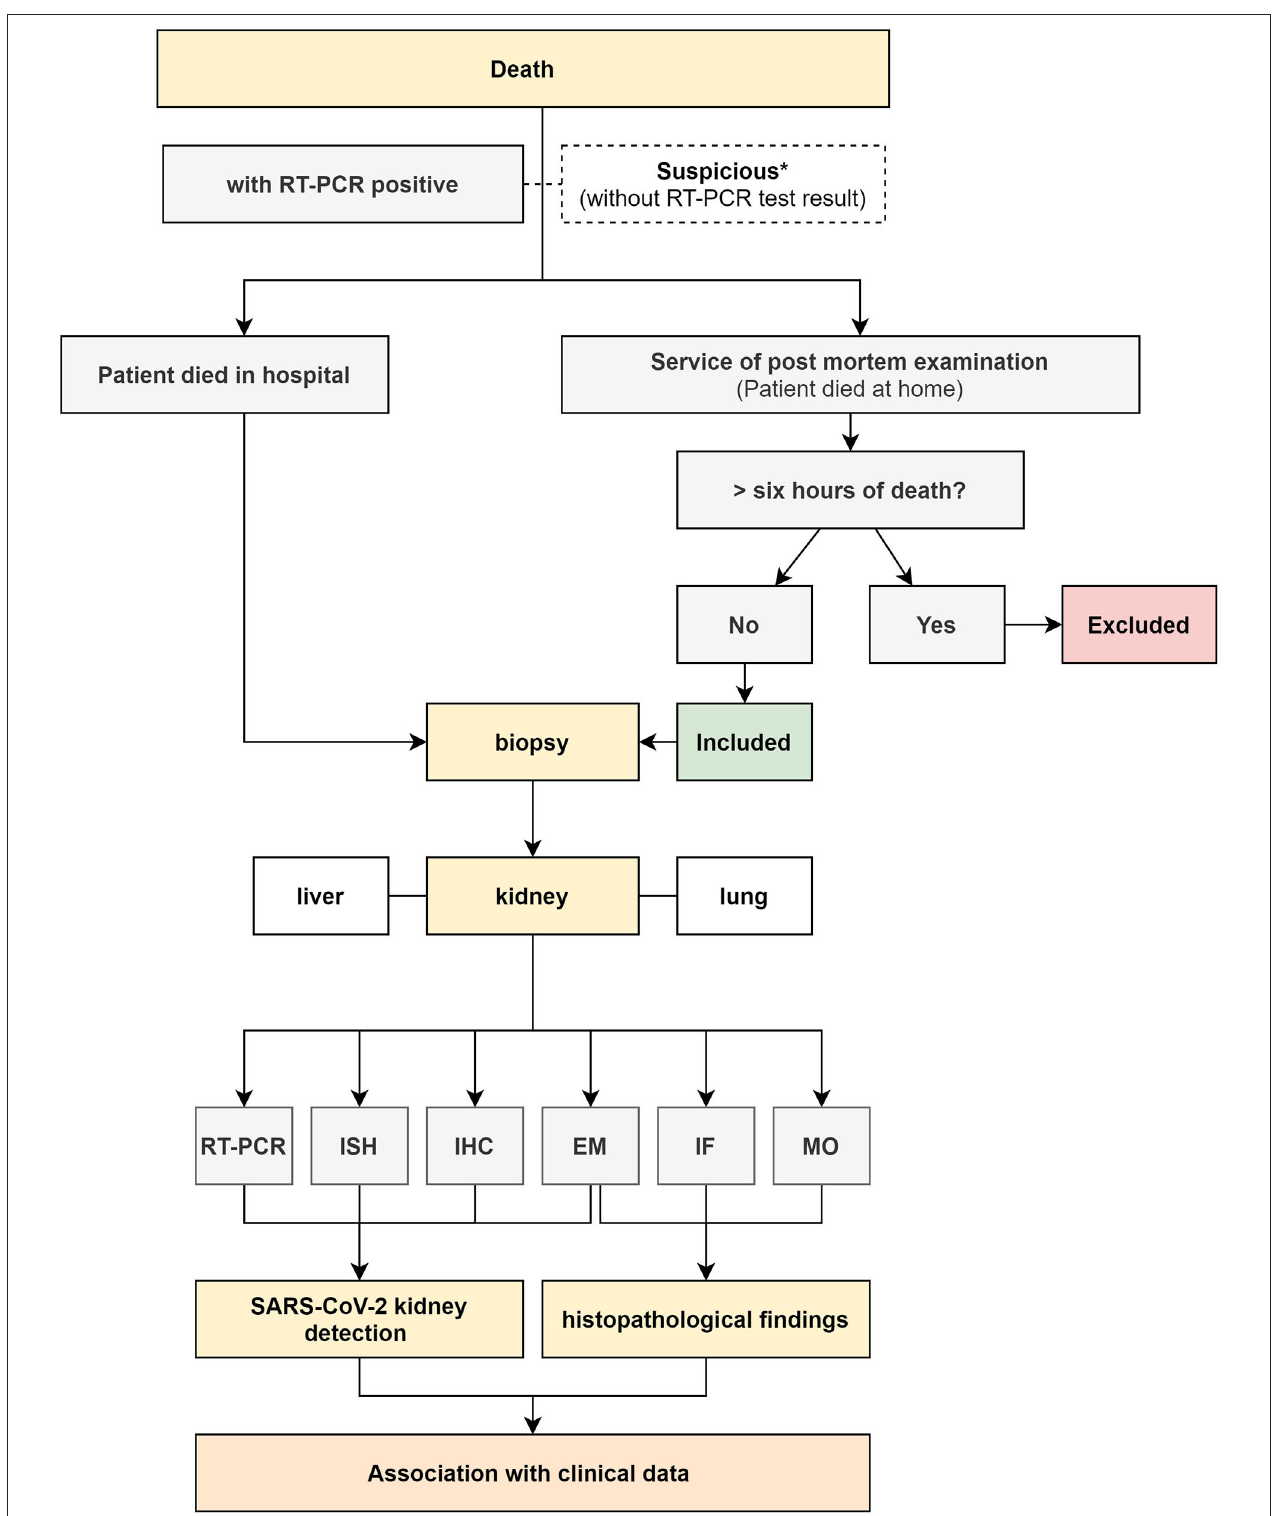
FIGURE 2 | Flowchart of collection and processing of death biopsies associated with COVID-19. RT-PCR (Reverse-Transcriptase Polymerase Chain Reaction); ISH ( in situ hybridization); IHC (immunohistochemistry); MO (light microscopy); IF (immunofluorescence); EM (electron microscopy); *(collected and discarded due to a negative RT-PCR